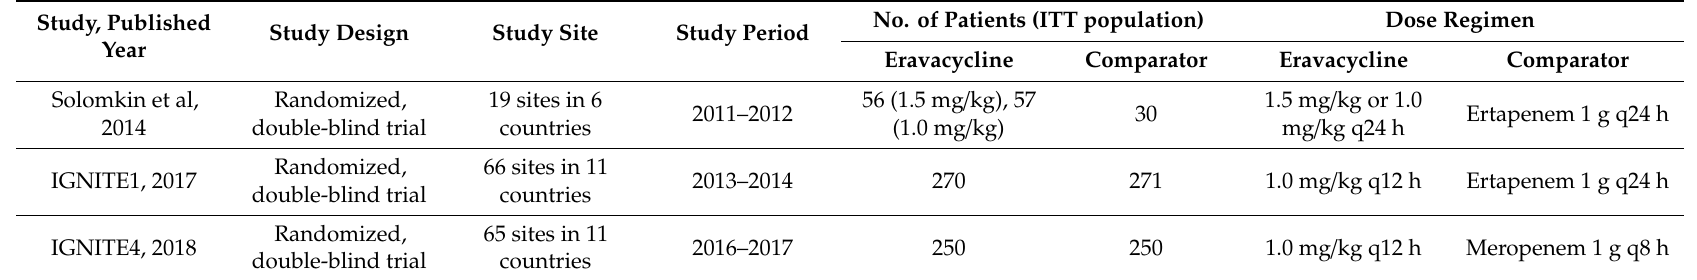
Table 1. Characteristics of included studies.